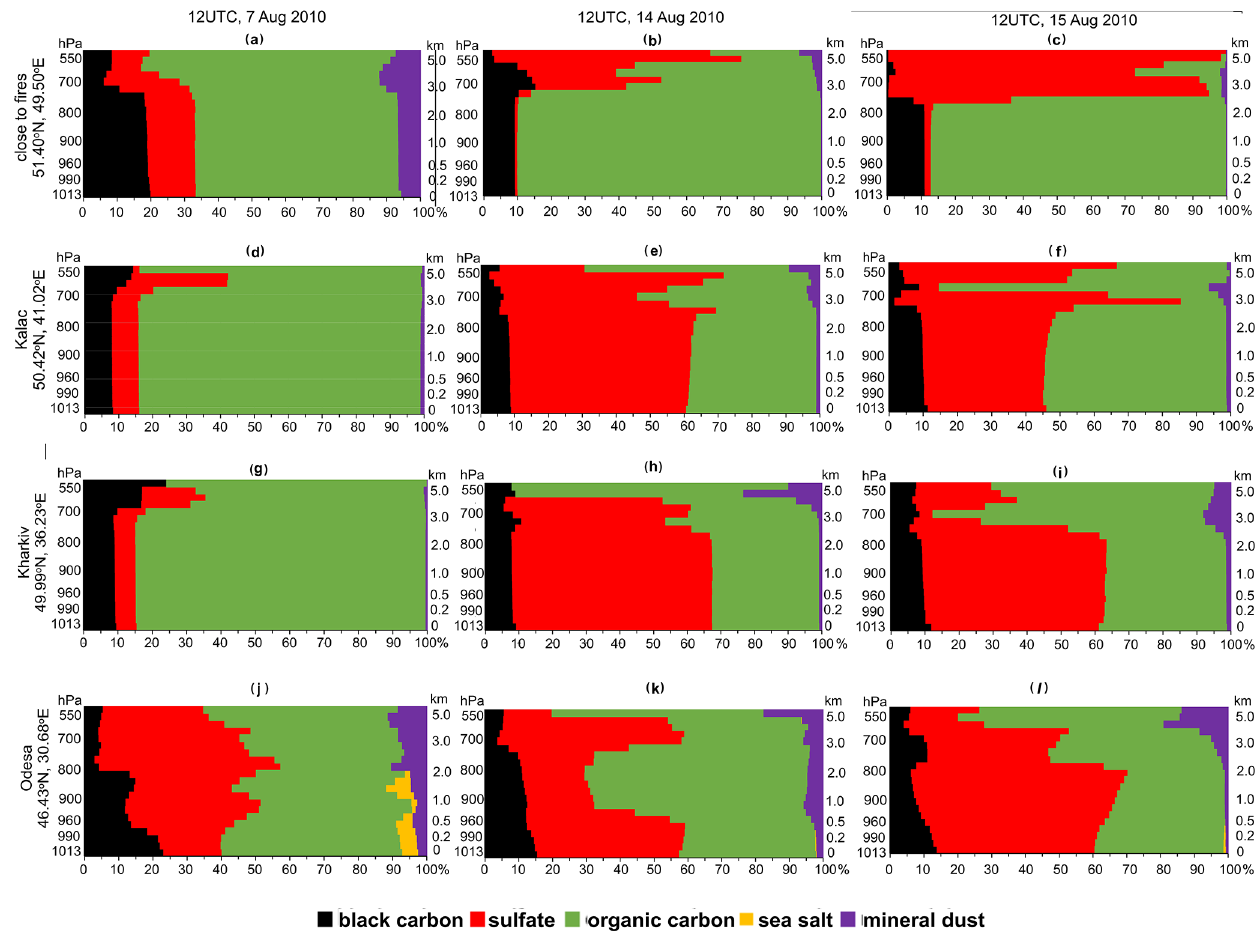
Figure 6. Vertical distribution of the ratio of aerosol compounds at different sites at 12:00UTC on 7 August (a, d, g, j) , 14 August (b, e, h, k) , and 15 August (c, f, i, l) 2010.